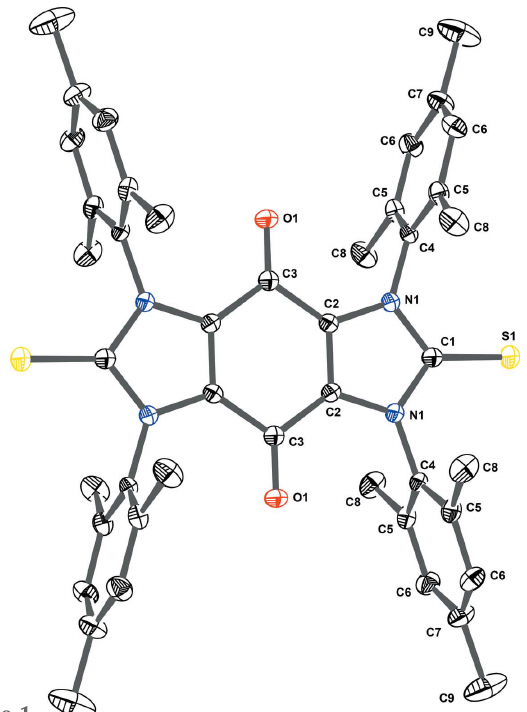
Figure 1 Molecular structure of the title compound with atom labeling. Displace- ment ellipsoids are drawn at the 50% probability level and all hydrogen atoms are omitted for clarity. Unlabeled atoms are generated by the symmetry operation ( (cid:4) x , (cid:4) y , z ), ( (cid:4) x , y , (cid:4) z and ( x , (cid:4) y , (cid:4) z